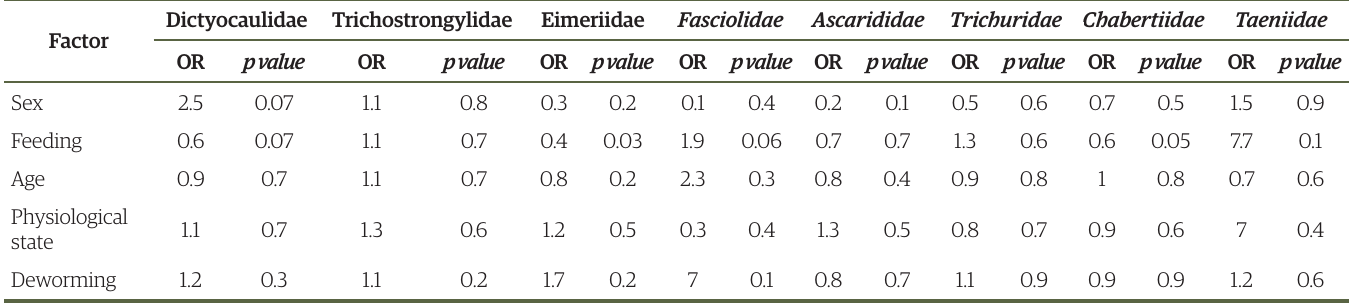
Table 3. Risk factors for the different families infection following analysis by flotation technique in sheeps from Ubaté - Colombia obtained by logistic regression